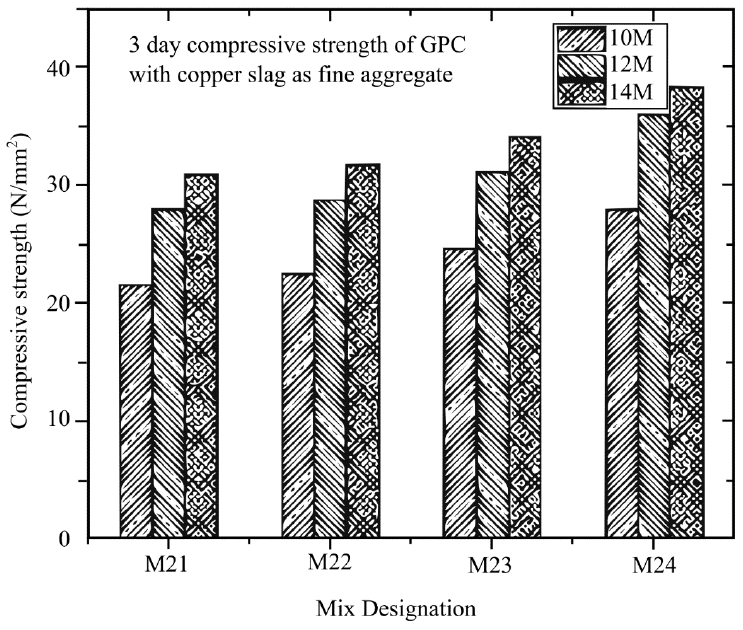
Figure 14. Different molarities in the mix design of GPC and copper slag at 3 days [145].